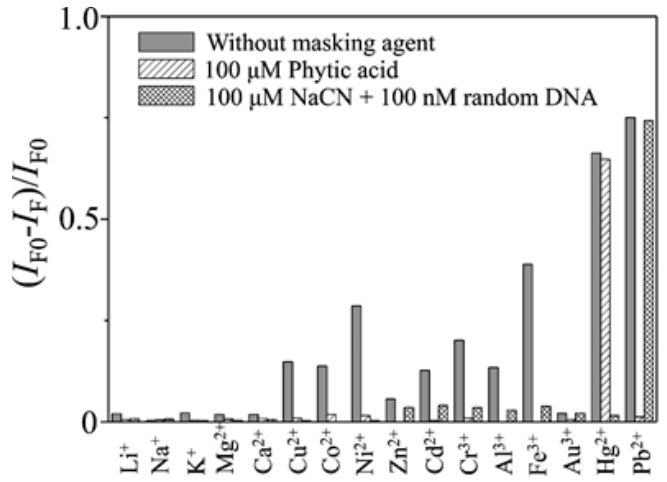
Figure 5. Quenching efficiency ( I F0 − I F )/ I F0 of the fluorescence intensity (518 nm) of the TBA-based sensor in the presence of metal ions in the absence and presence of masking agents. Concentrations: Hg 2+ , 1.0 μ M; Pb 2+ , 100 nM; Li + and Na + , 100 μ M; K + , Mg 2+ , and Ca 2+ , 10 μ M; other ions, 1.0 μ M. Reprinted with permission from [61]. Copyright 2009 American Chemical Society.